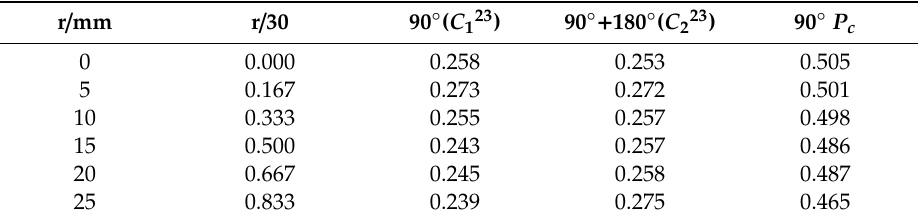
Table 6. The normalized P c of the experiment and simulation. Table 5. The measured capacitance (pF) and relative proportion of capacitance between E2 and E3 ( P c ).